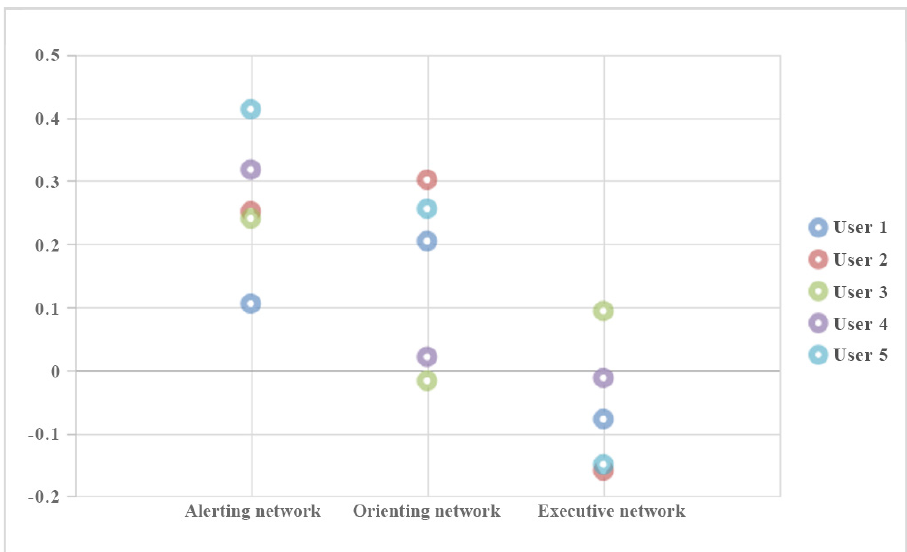
Figure 18. The rate of change of the attention network parameters.